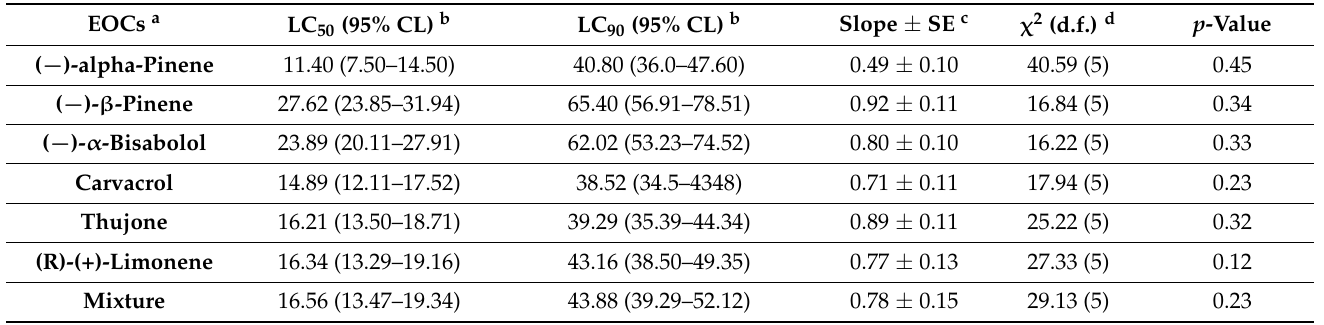
Table 4. Toxicity of different EOCs against B. dorsalis